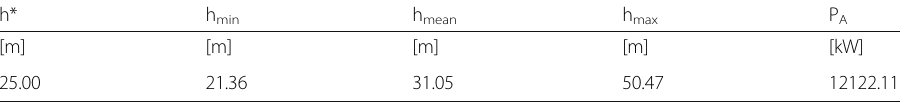
Table 2 Hydraulic characteristics of the water distribution network of Parete h*